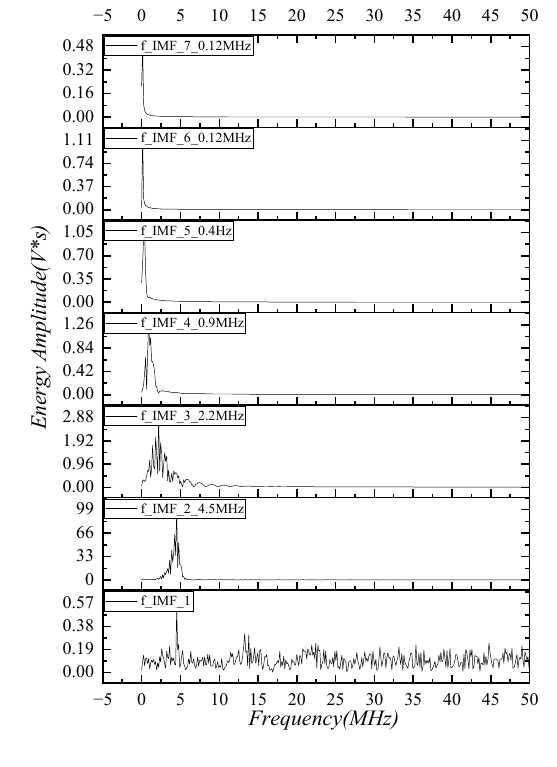
Figure 7. Statistics of ultrasonic echo signals in Figure 6.